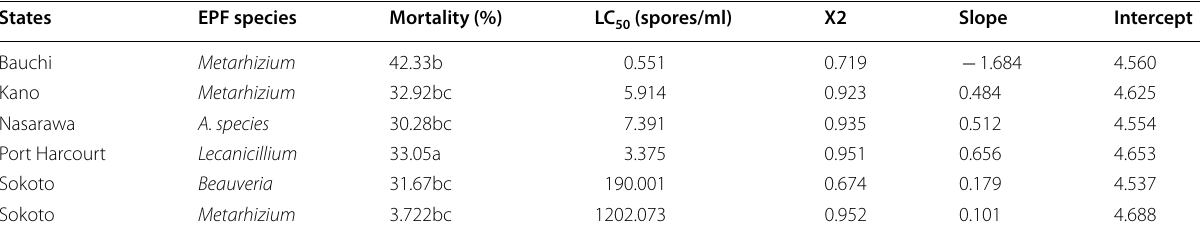
abc: The letters signifies that mean mortality values that did not share the same are significantly different agar; LC 50 : Lowest concentration the causes 50% mortality; LC 90 : Lowest con- centration the causes 90% mortality; µg: Microgram; µl: Microliter; LSD: Least